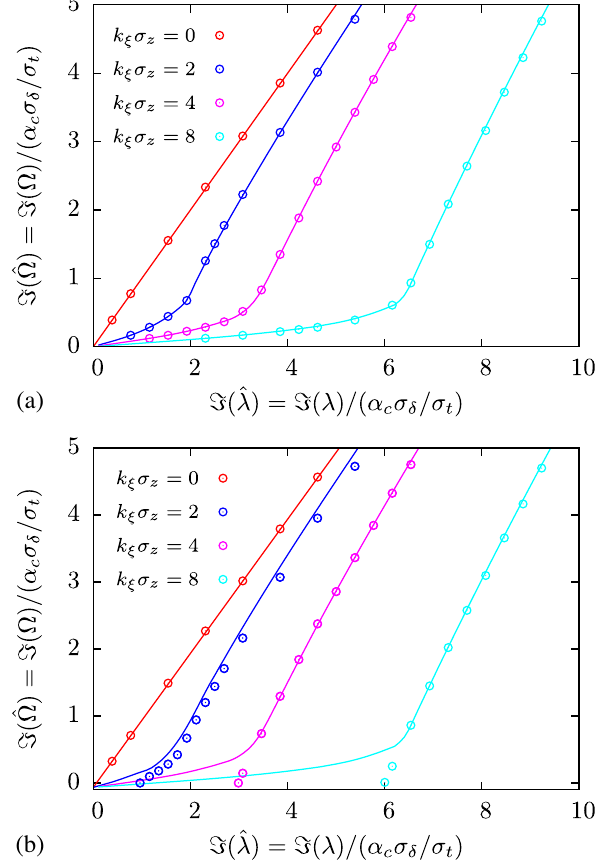
FIG. 3. Comparison of the growth rates obtained by tracking ∝ z 2 . Tracking in (dots) to those of theory (solid lines) when V z panel (a) is Hamiltonian with no damping or diffusion, and we see very good agreement between theory and simulation. Panel (b) includes synchrotron emission in tracking as a stochastic process that leads to both damping and diffusion. In this case the additional physics of diffusion stabilizes the motion when the instability is weak and Eq. (42) applies; in contrast, when the growth rate is larger than the chromatic tune spread, ℑ ð λ Þ ≳ 3 ξω σ 4 , tracking shows that diffusion does not affect 0 δ = the growth rate, and ℑ ð Ω Þ is approximately that given by Eq. (43) minus the scaled damping of